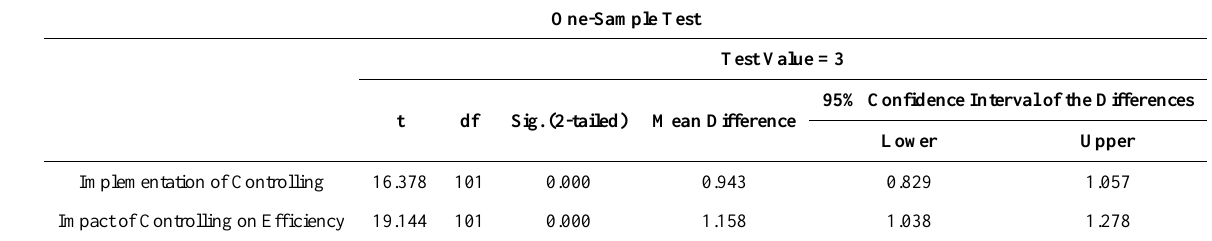
Table 7. One-sample test